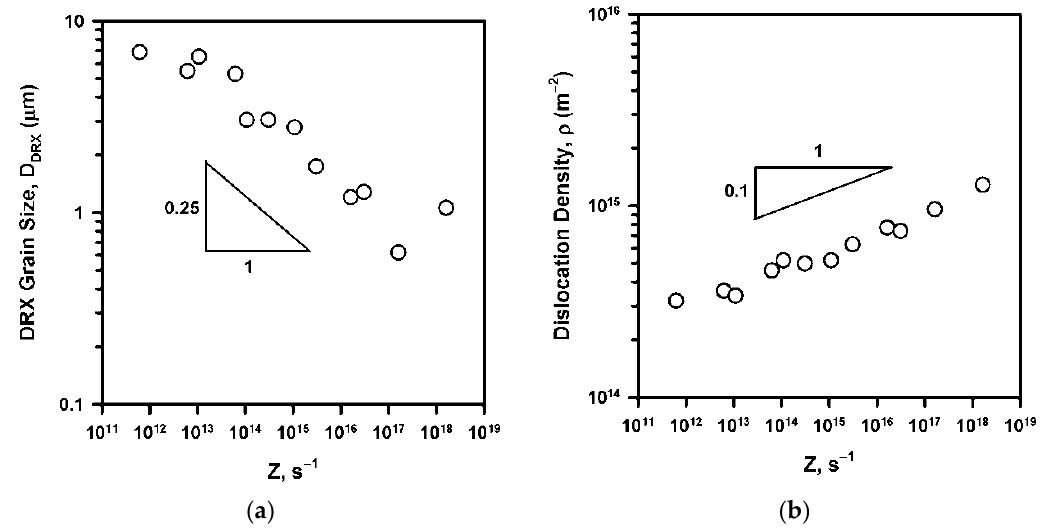
Figure 9. Effect of deformation conditions (Z) on the DRX grain size ( a ) and dislocation density ( b ).